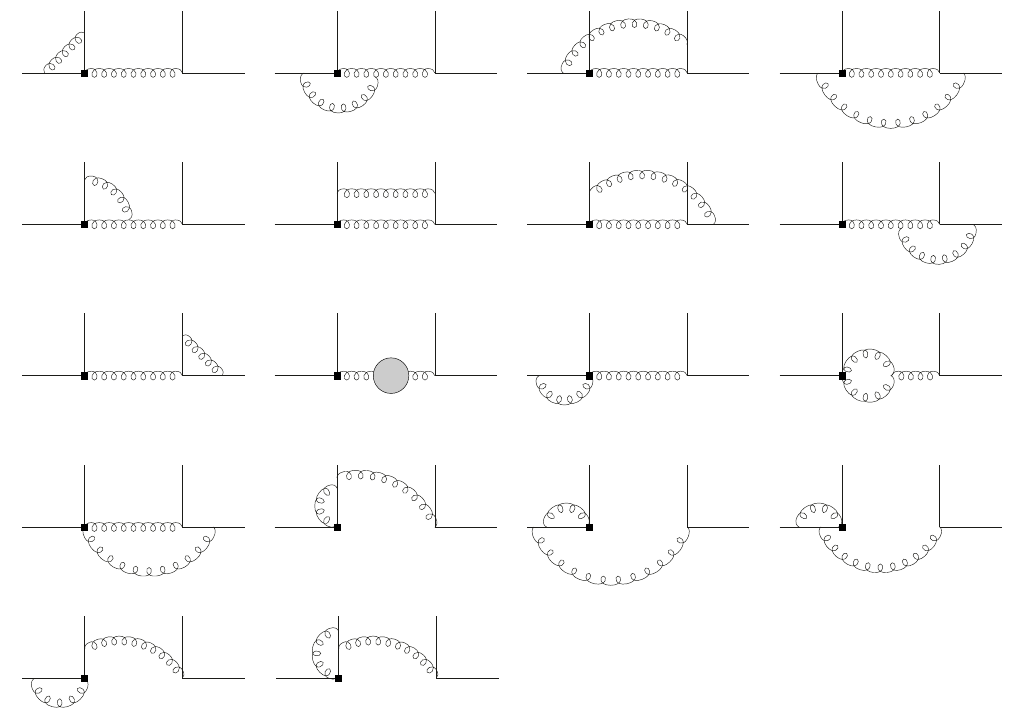
Figure 6 . One-loop diagrams of the chromomagnetic dipole operator Q